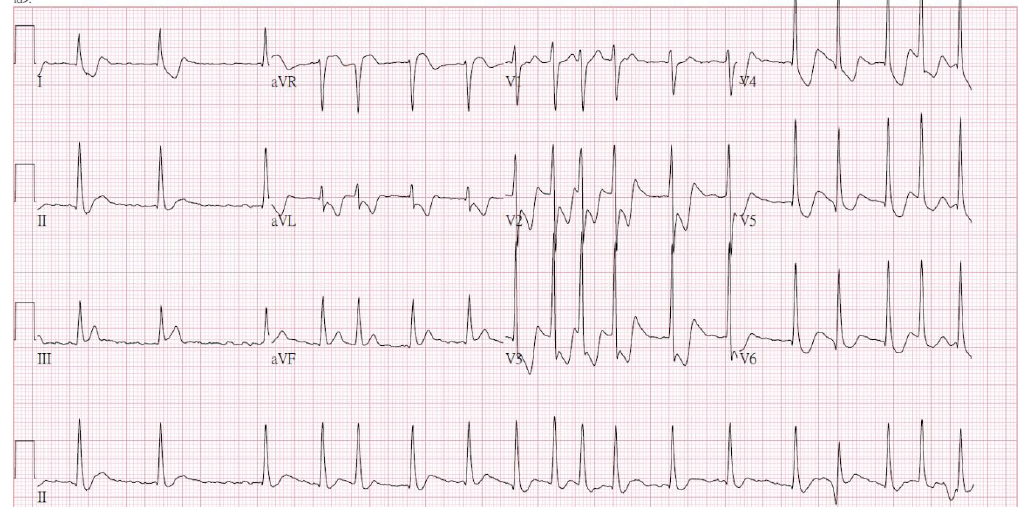
Figure 2. The follow-up electrocardiogram showed atrial fibrillation with a rapid ventricular response and ST-segment depression in V 2-6 .